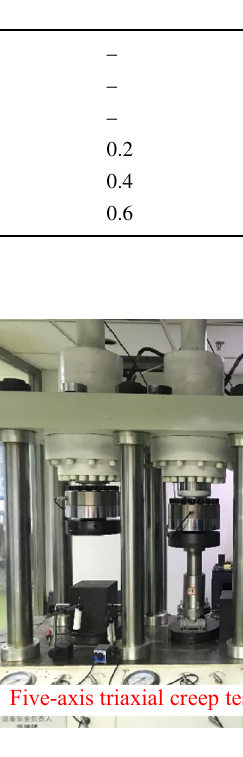
Fig. 3 Creep test system of crushed